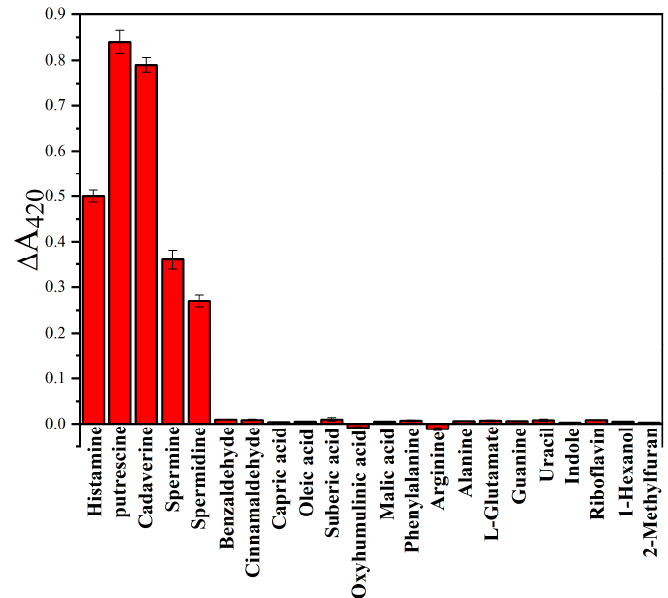
Figure 3. Absorbance of Ag NP films decreased at 420 nm in reaction with BAs or interfering compounds (Histamine, Putrescine, Cadaverine, Spermine, Spermidine: 20 mg/m 3 . Benzaldehyde, Cinnamaldehyde, Capric acid, Oleic acid, Suberic acid, Oxyhumulinic acid, Malic acid, Phenylalanine, Arginine, Alanine, L ‐ Glutamate, Guanine, Uracil, Indole, Riboflavin, 1 ‐ Hexanol, 2 ‐ Methylfuran: 50 mg/m 3 ). Each data point is the mean of six replicate samples (mean ± standard deviation).